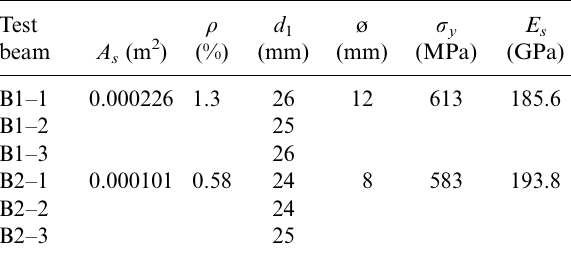
Table 2. Main reinforcing characteristics of tested